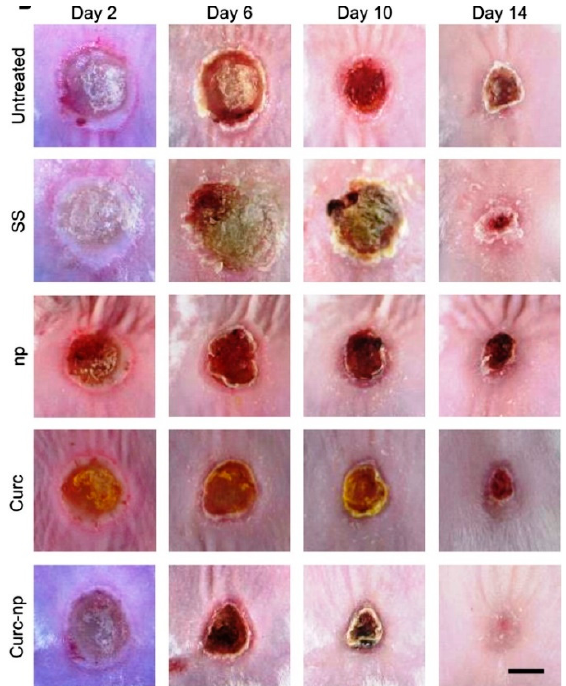
Figure 5. Hotographs of the wound healing process in a murine burn model treated with curcumin nanoparticles (curc-np) compared to untreated, silver sulfadiazine (SS), control np (np) and curcumin (curc). Scale bar = 5 mm. Reproduced with permission from [111] , copyright 2015 Elsevier B.V.).